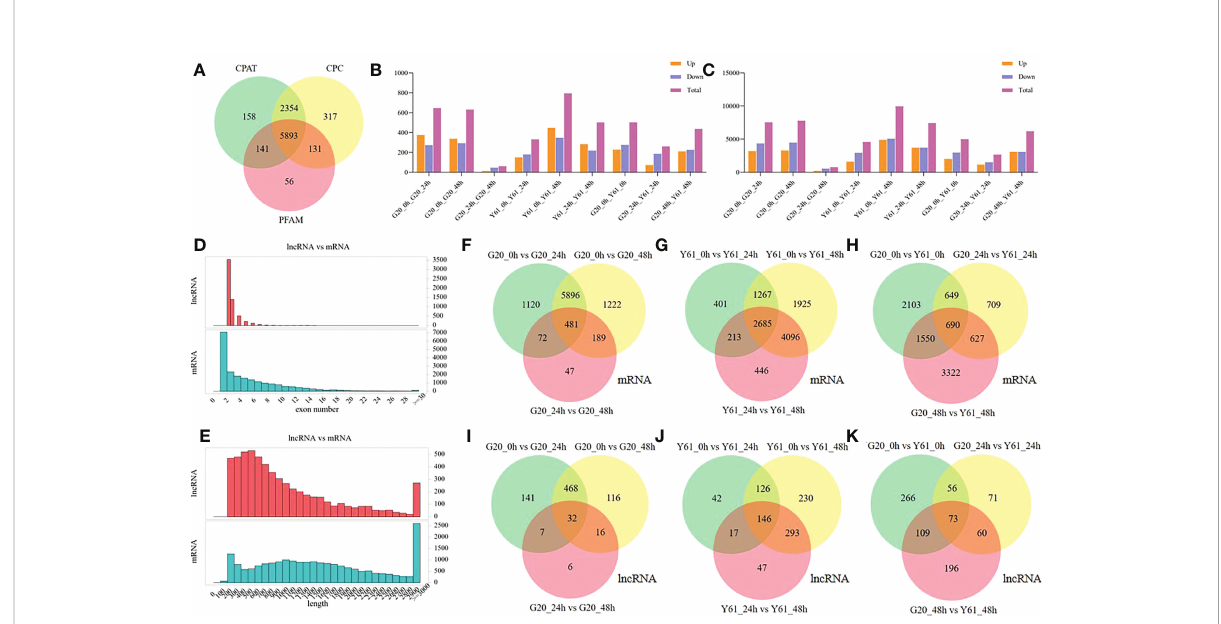
FIGURE 2 LncRNA identi fi cation and differential expression analysis of lncRNAs and mRNAs. (A) Venn diagram of the differentially expressed lncRNAs identi fi ed using CPAT, CPC, and PFAM in the 18 RNA-sequencing samples. (B) Number of up- and down-regulated lncRNAs between the different groups (Up is high expression in the former of the compared combination, while Down is low expression in the former of the compared combination); (C) Number of up- and down-regulated mRNAs between the different groups; (D) Comparison of the number of exons between the mRNA and lncRNA; (E) Comparison of the length distribution of the mRNA and lncRNA; (F) Venn diagram of the differentially expressed mRNAs between samples of G20 at different time points; (G) Venn diagram of the differentially expressed mRNAs between samples of Y61 at different time points; (H) Venn diagram of the differentially expressed mRNAs between samples of G20 and Y61 at a particular time point; (I) Venn diagram of the differentially expressed lncRNAs between the samples of G20 at different time points; (J) Venn diagram of the differentially expressed lncRNAs between samples of Y61 at different time points; (K) Venn diagram of the differentially expressed lncRNAs between samples of G20 and Y61 at the same time